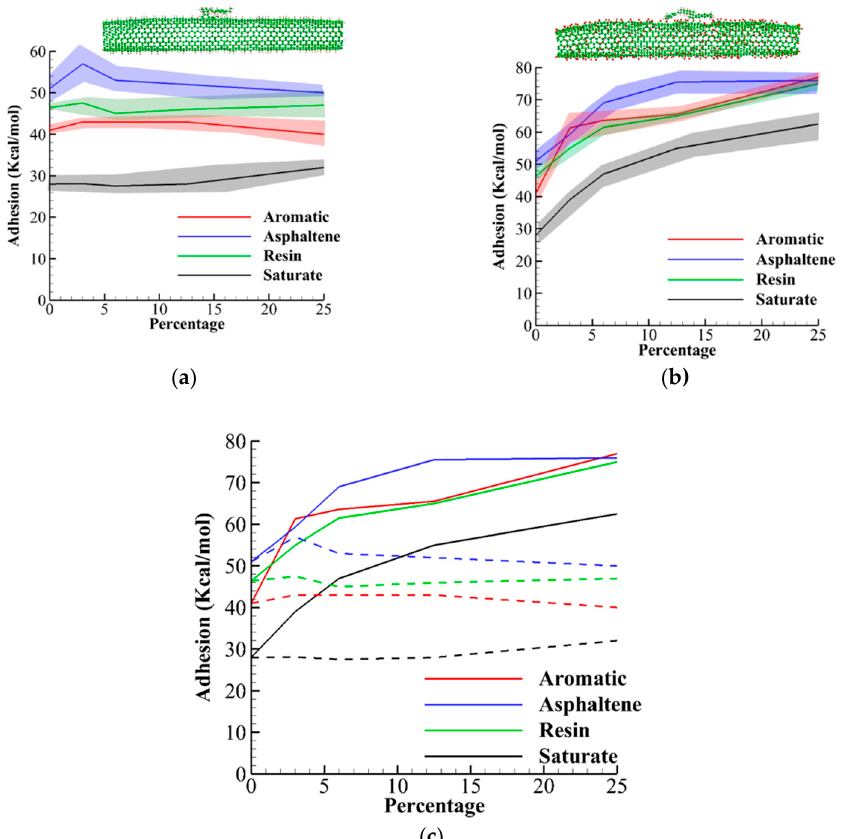
Figure 6. Adhesion energy of SARA and different dosages of hydrogenated and oxygenated CNTs. ( a ) SARA-hydrogenated CNTs, ( b ) SARA-oxygenated CNTs, and ( c ) comparison of SARA- hydrogenated (dashed lines) and SARA-oxygenated CNTs (solid lines).